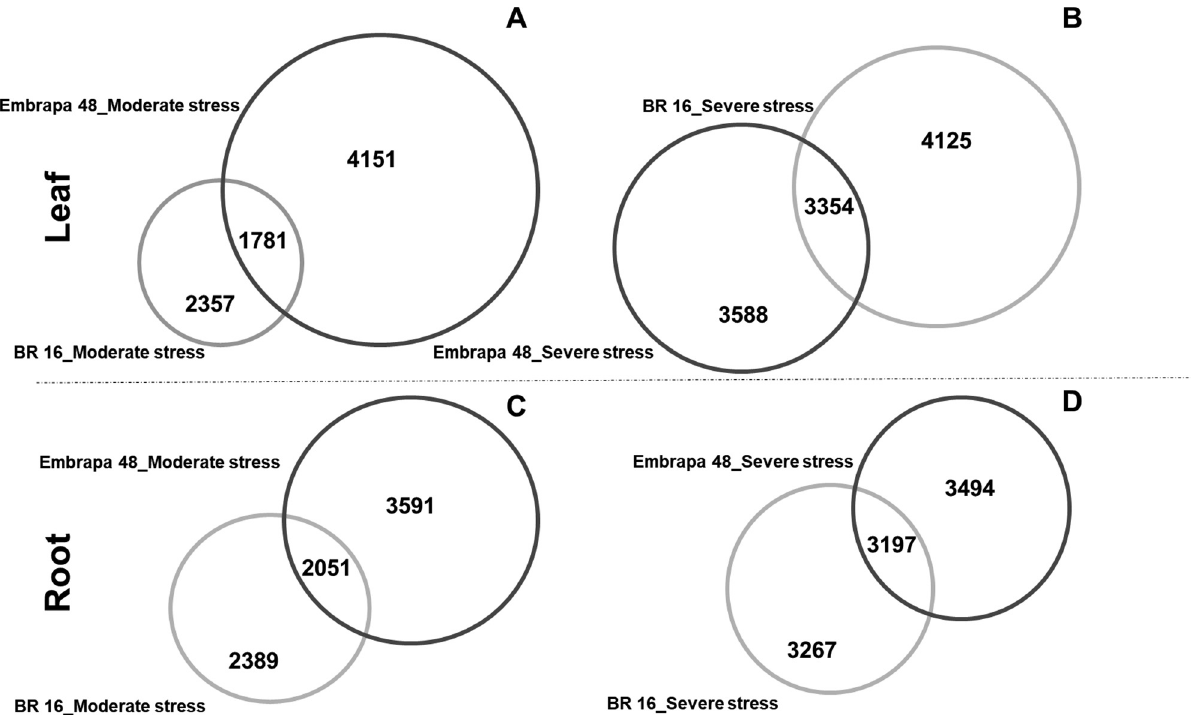
Figure 1 - Venn diagram. Number of genes differentially expressed in both libraries (moderate and severe water defict stress), highlighting common genes between cultivars. (A) Leaf from BR 16 and Embrapa 48 in moderate stress library; (B) leaf from BR 16 and Embrapa 48 in severe stress library; (C) root from BR 16 and Embrapa 48 in moderate stress library; (D) root from BR 16 and Embrapa 48 in severe stress library. The size of the circle repre- sents the number of genes. Dark gray circles represent the cultivar Embrapa 48 and light gray circles refer to the cultivar BR